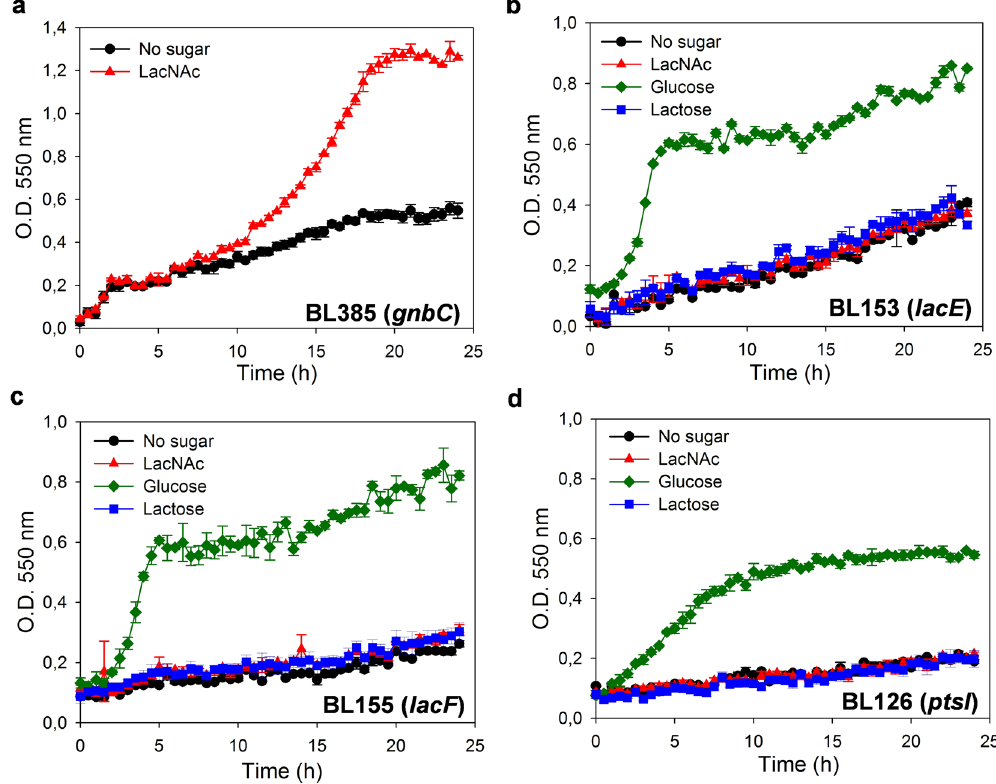
Figure 3. Growth curves of Lactobacillus casei mutant strain BL385 ( gnbG ) ( a ) on sugar-free MRS without carbon source (black) or with N -acetyllactosamine (LacNAc) (red). Data presented are mean values based on at least three replicates. Error bars indicate standard deviations. Growth curves of L. casei mutant strain BL153 ( lacE ) ( b ), L. casei mutant strain BL155 ( lacF ) ( c ) and L. casei mutant strain BL126 ( pstI ) ( d ) on sugar-free MRS without carbon source (black), with N -acetyllactosamine (LacNAc) (red), glucose (green) or lactose (blue). Data presented are mean values based on at least three replicates. Error bars indicate standard deviations.